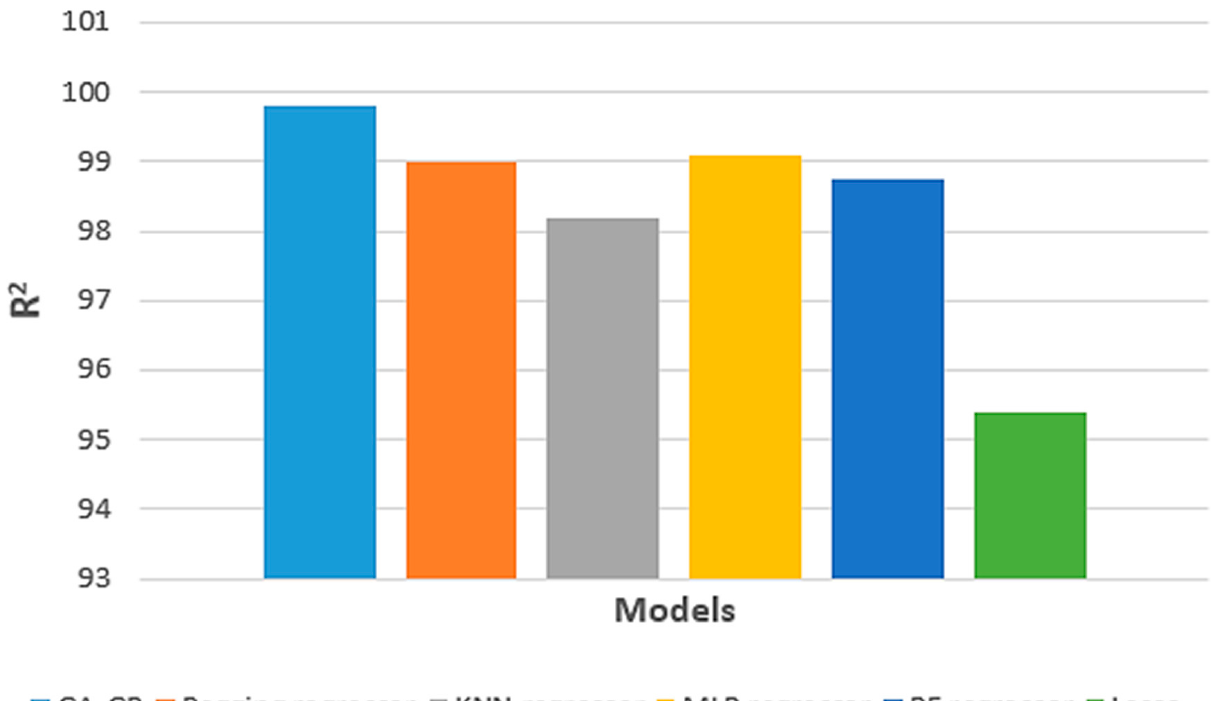
Figure 3. Comparison between the models used in the term of coefficient of determination (R 2 ) using OPrice dataset.